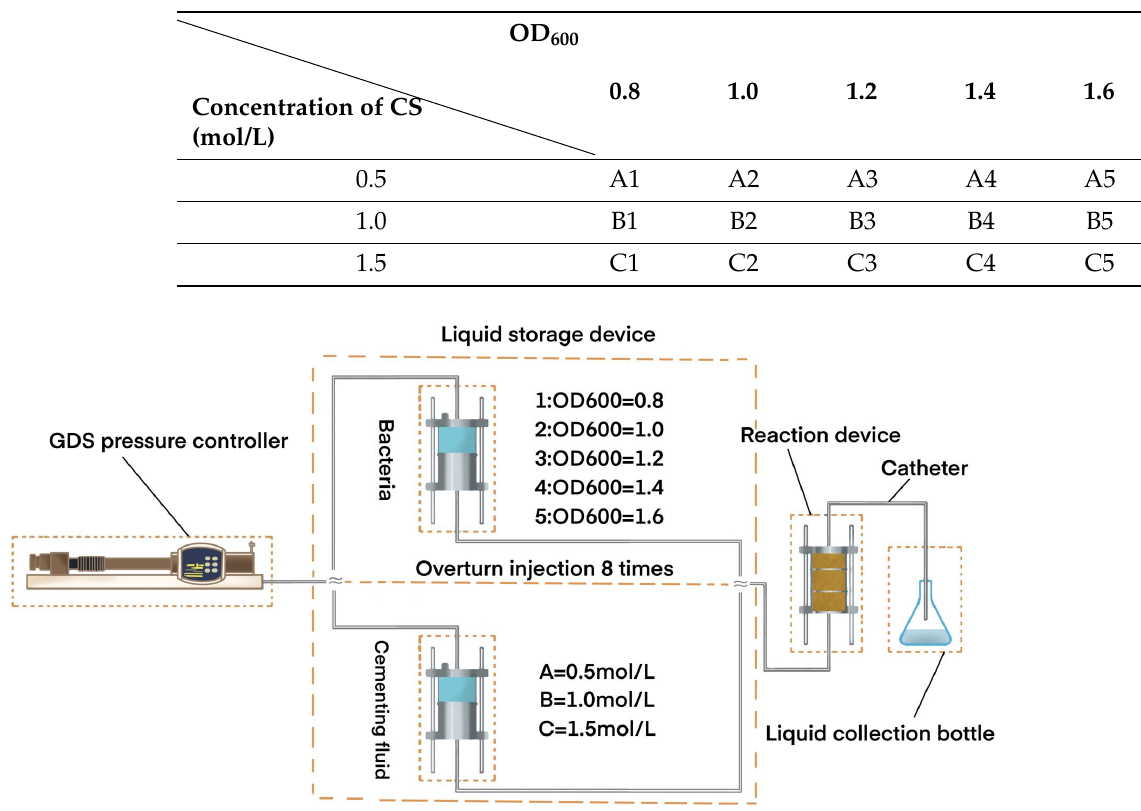
Table 2. Test scheme and sample label.